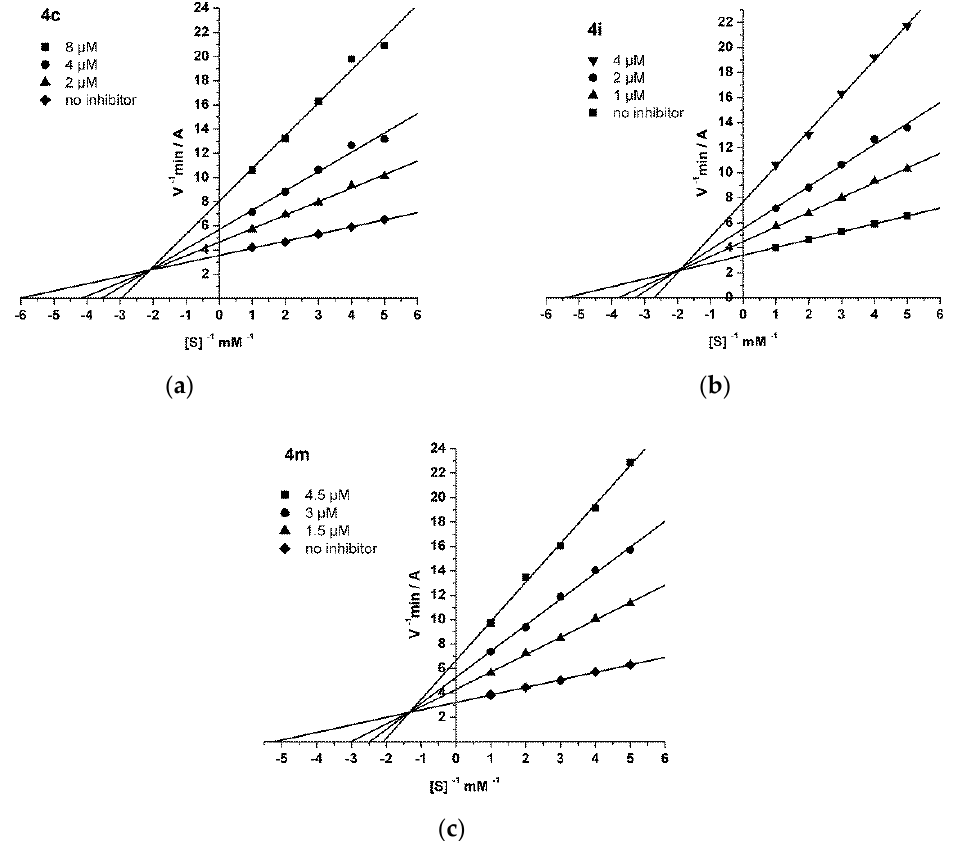
Figure 1. Steady state inhibition of AChE by compounds 4c ( a ), 4i ( b ), and 4m ( c ). The Lineweaver– Burk reciprocal plots of the initial reaction rate and substrate concentration in the presence of inhibitors 4c, 4i, and 4m (three increasing concentrations) and without inhibitors are presented. The plots ( a – c ) show mixed type